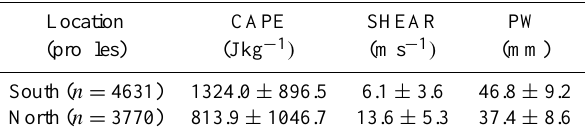
Table 2. Average and standard deviation of CAPE, SHEAR, and PW over the Eastern United States during 2001–2011. See Fig. 2 for radiosonde sites used in the